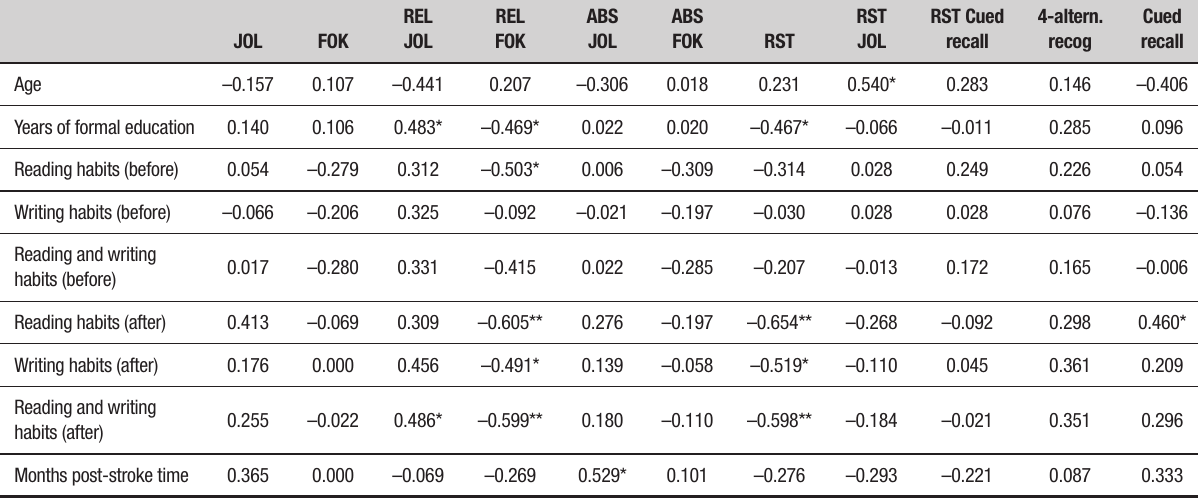
Figure 2. Cases depicting a double dissociation between memory monitoring and memory control (cases R4, R5, L5 and L3) and a single dissociation between memory control and memory capacity (case L3). Measures are from the Metamemory Experimental Task. Score under the dotted line indicates deficit (p<0.05). Percentage of healthy population, estimated from the control group falling below individual’s deviant score and the 95% confidence interval (CI) is displayed at the bottom. Table 3. Spearman Correlations between measures of memory and metamemory and sociodemographic, health and reading and writing habits data for the clinical group